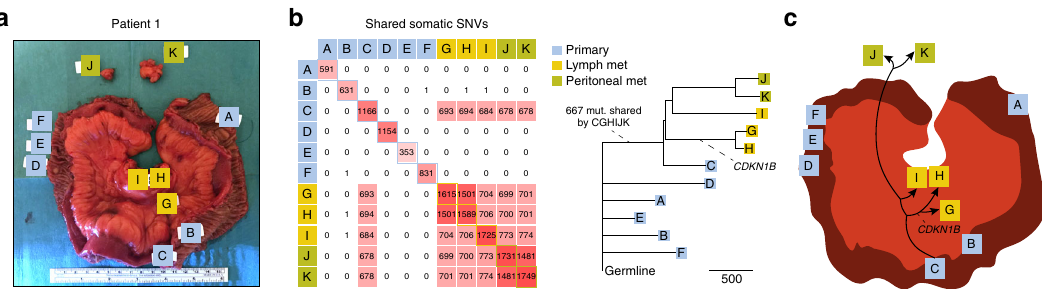
Fig. 1 Whole genome sequencing of 11 primary tumors and metastases from a single SI-NET patient supports independent clonal evolution. a Section of the small intestine from a patient (Patient 1) harboring six primary tumors (A – F), three lymph node metastases (G – I), and two peritoneal metastases (J – K). b Pairwise analysis of shared somatic SNVs based on whole genome sequencing. Primary tumor C and the fi ve metastases shared a common set of 667 mutations. A maximum parsimony phylogenetic tree is shown, with the number of SNVs in each branch given by the scale marker. An indel in CDKN1B , a known driver event, is indicated. Bootstrap support was > = 98% for all major branches. c Proposed model, where all metastases originate from a single primary tumor, and where all primaries are unrelated in terms of somatic evolution. Met, metastasis; SNV, single nucleotide variant. Source data are provided as a Source data fi le.